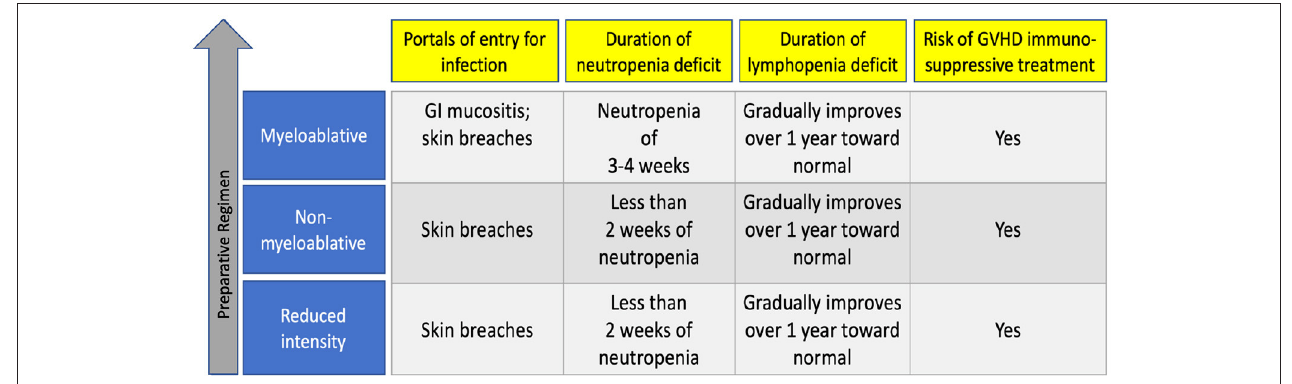
FIGURE 1 | Factors associated with infections by preparative therapy